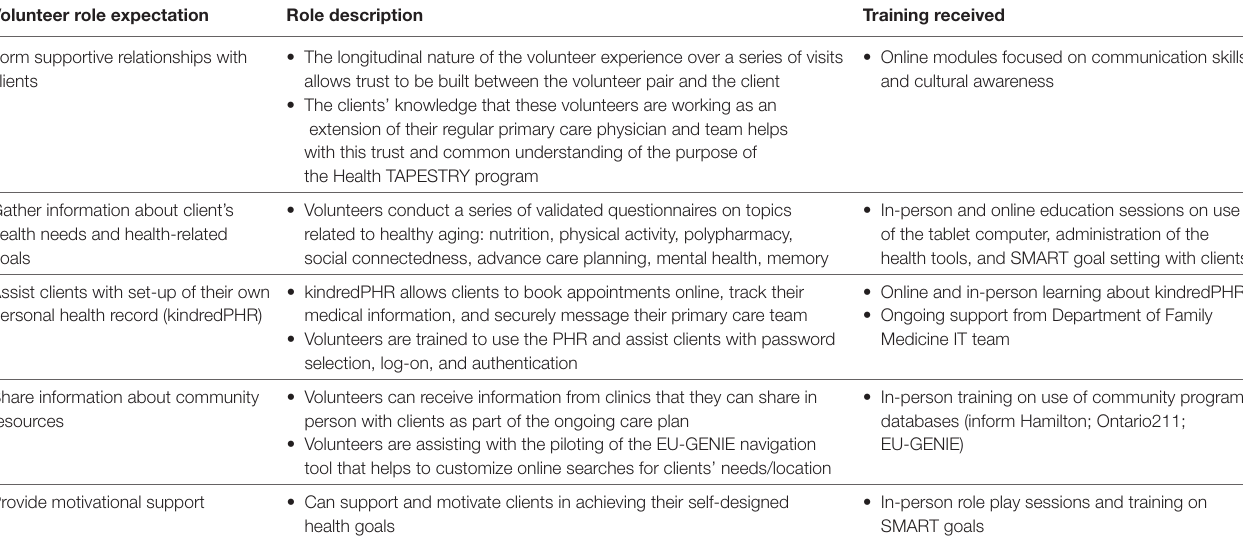
table 1 | Volunteer role expectations, role descriptions, and associated training received for role